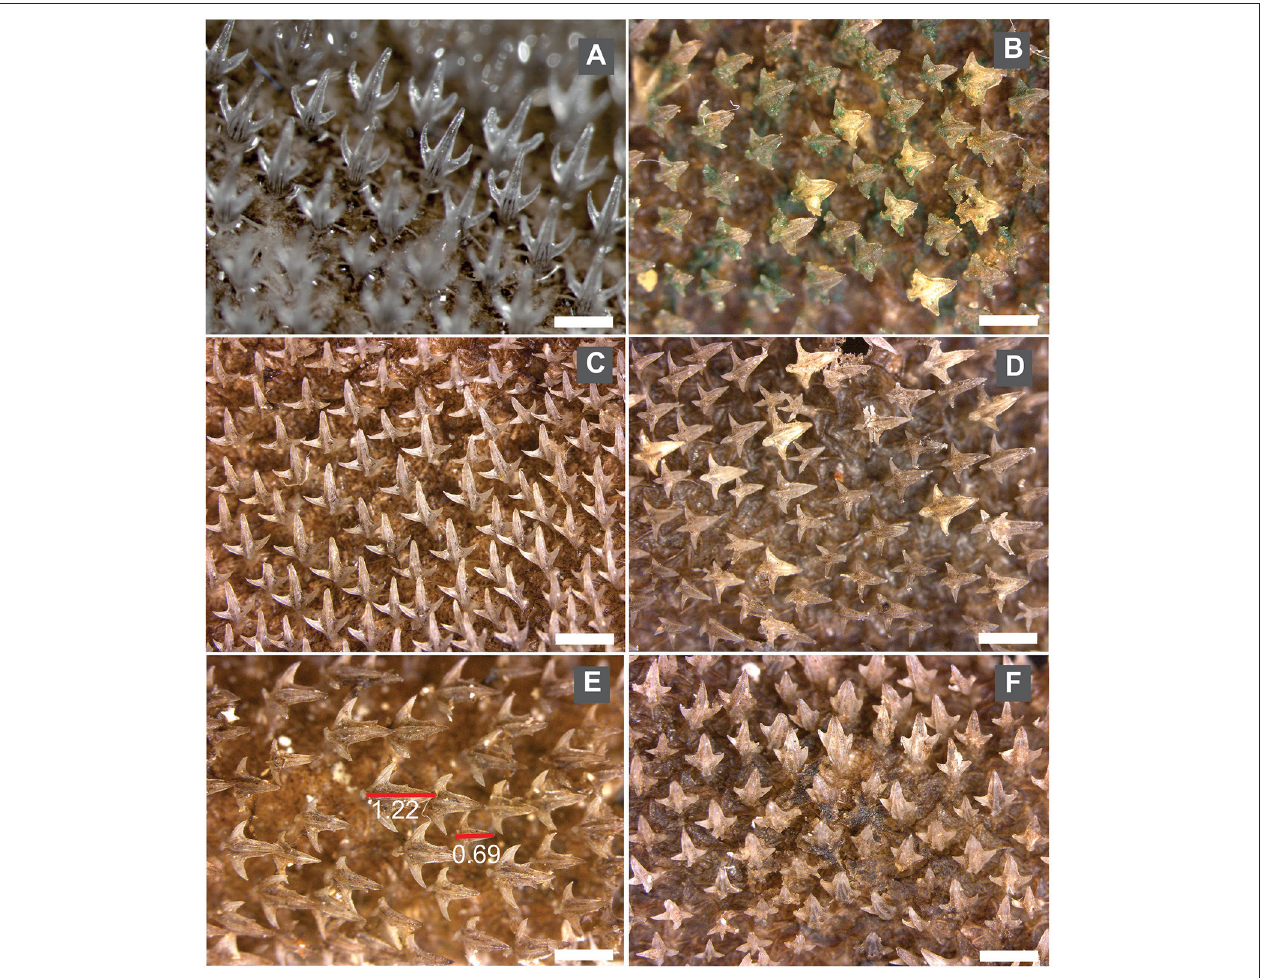
FIGURE 5 | Images of dermal denticles belonging to different Deania species from the NE Atlantic (A) Dermal denticles from D. profundorum ; (B) D. calcea2 MAD115 (see Figure 2 ), a female with TL = 93.5cm; (C) D. calcea MAD117, a male with TL = 83.7cm; (D) D. calcea MAD110, a female with TL = 83.6. The white mark in each image corresponds to